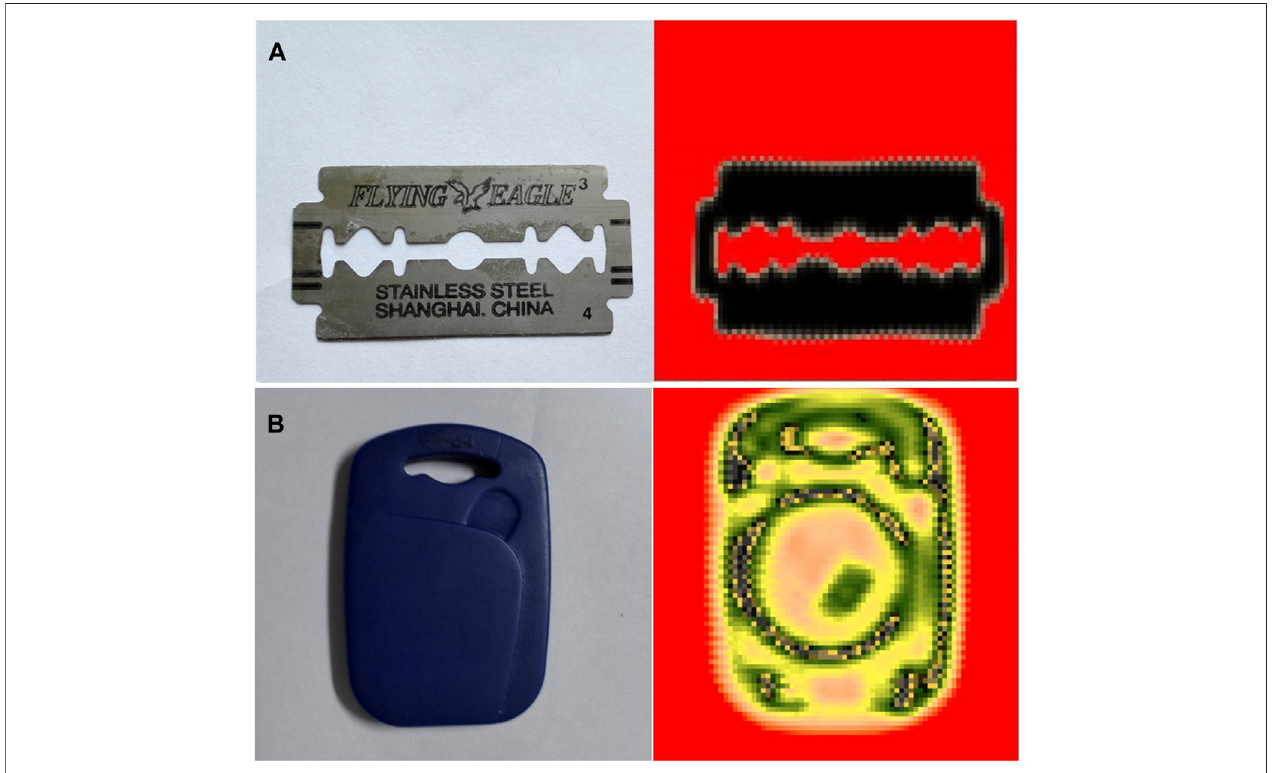
FIGURE 10 | Photographs and THz images of a metal blade (A) and access card (B)